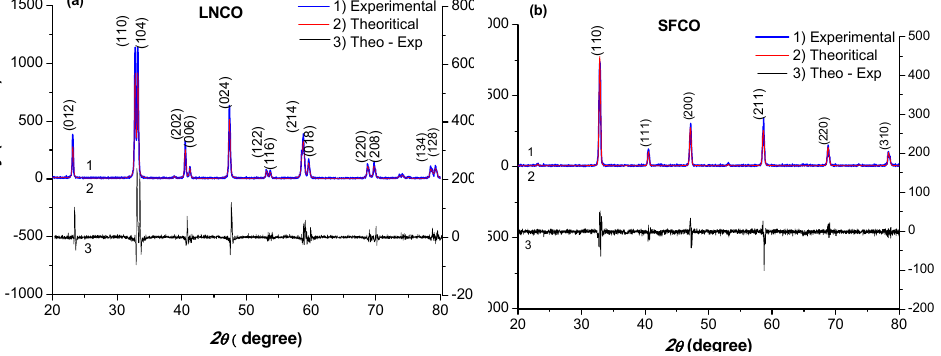
Figure 2. XRD patterns for the powder samples of LNCO ( a ) and SFCO ( b ). For both samples, pattern 1 corresponds to the experimental measurement data; pattern 2 is calculated by the Rietveld refinement; and the third pattern is the difference of the theoretical and experimental results.